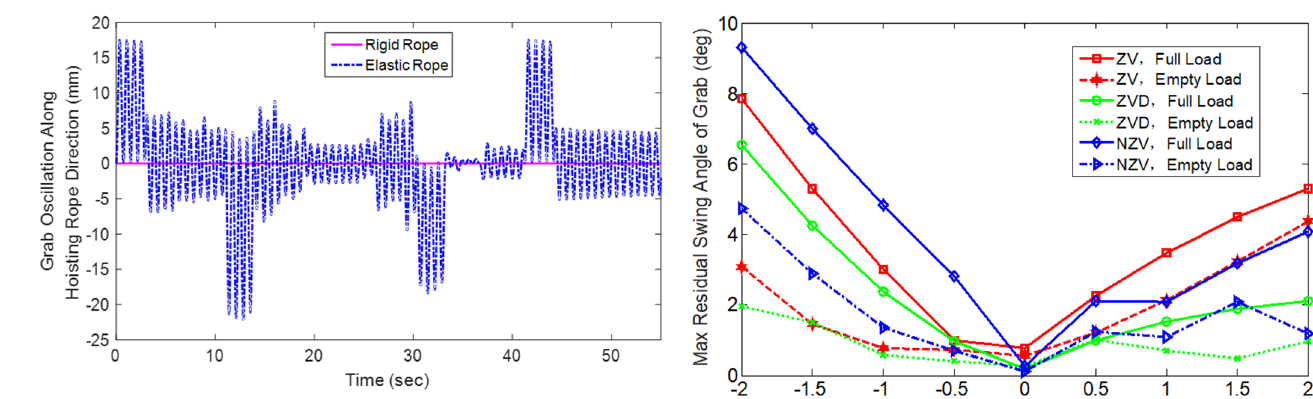
Fig. 6. Oscillation curve of grab in the direction of hoisting rope.